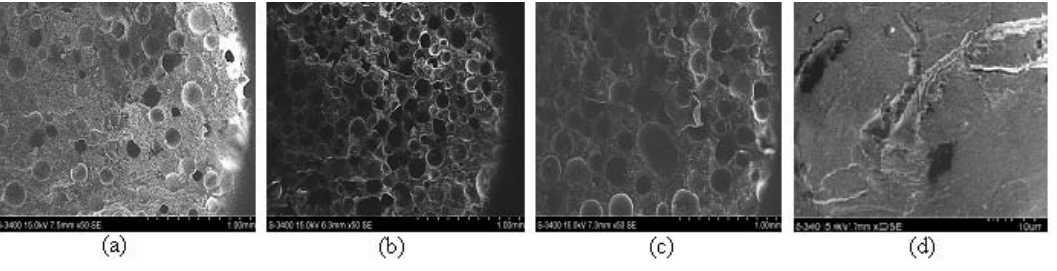
Figure 7. SEM analysis for a sample of the type: ( a ) Da 1.x. ( b ) Da 2.x. ( c ) Da 3.x. ( d ) epoxy